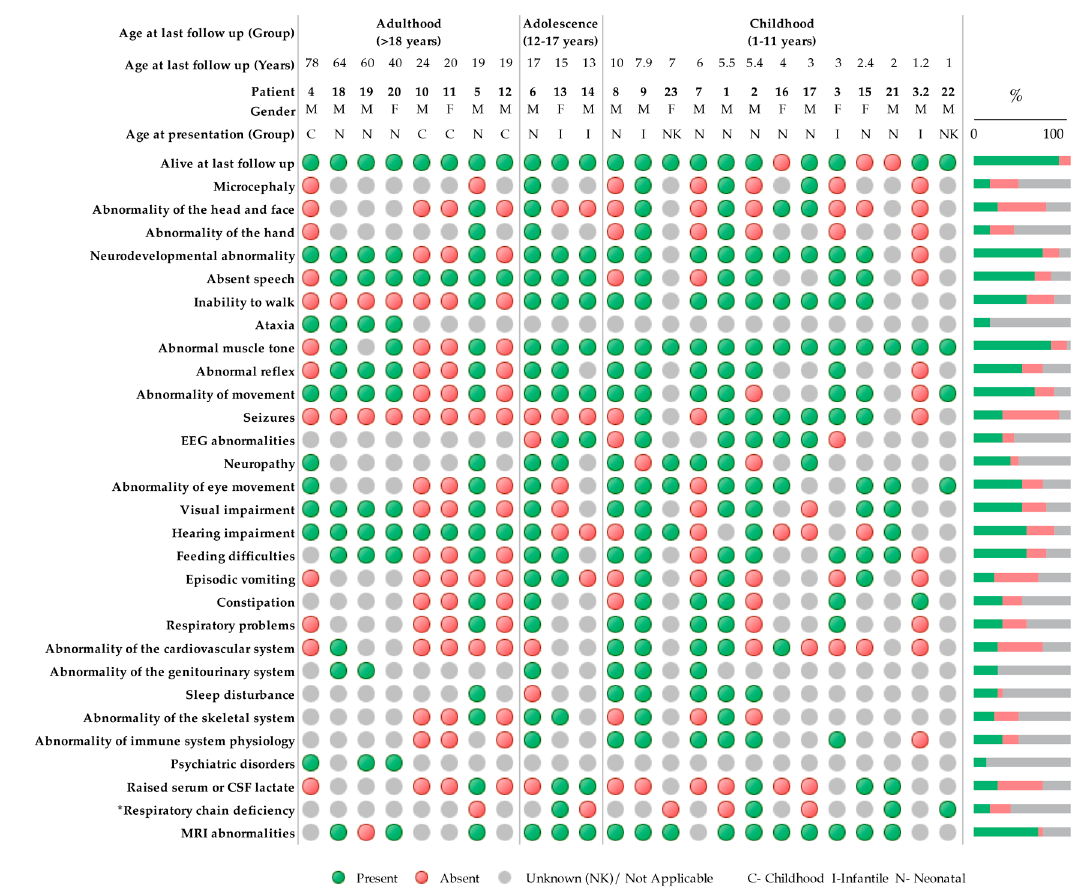
Figure 2. Clinical symptoms using Human Phenotype Ontology (HPO) terminology of patients with bi-allelic PNPT1 variants ( n = 24). Green indicates a present phenotype, red indicates an absent phenotype, and gray is unknown or not applicable. * Respiratory chain deficiencies refer to reported reductions in oxidative phosphorylation (OXPHOS) enzyme activity measured by spectrophotometric analysis in any tissue. Neonatal (0–28 days), infant (28 days–1 year), and